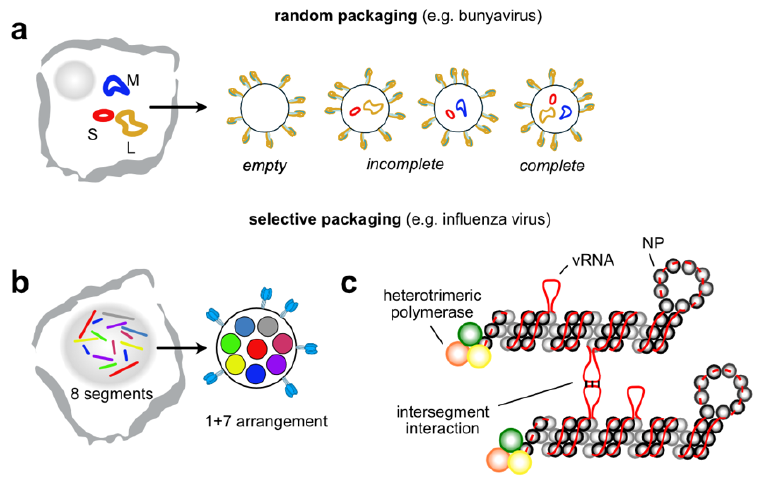
Figure 5. Segmented viruses package their genomes randomly or by using segment specific packaging signals. ( a ) Bunyavirus randomly package three genome segments, small (S), medium (M) and large (L), such that many progeny virions are empty or incomplete; ( b ) Influenza A virus package 8 genome segments selectively. Genome segments within budding virions are organized into a 1 + 7 arrangement with one central segment surrounded by seven others; ( c ) Influenza vRNAs are packaged as viral ribonucleoproteins (vRNPs). vRNAs are bound by nucleoprotein (NP) and a heterotrimeric polymerase. vRNA is incompletely coated by NP allowing for inter-segment vRNA- vRNA interactions to occur as a possible mechanism underlying the selective packaging